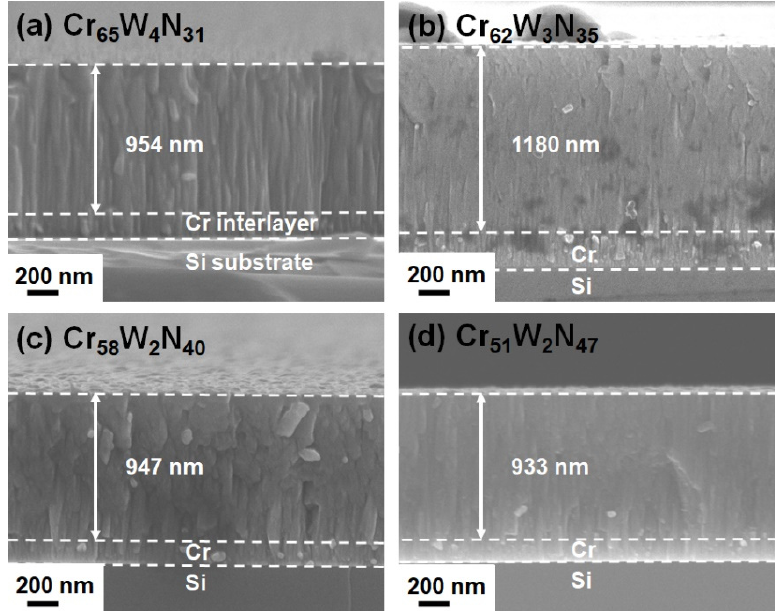
Figure 2. Cross-sectional FE-SEM images of ( a ) Cr 65 W 4 N 31 , ( b ) Cr 62 W 3 N 35 , ( c ) Cr 58 W 2 N 40 , and ( d ) Cr 51 W 2 N 47 coatings.